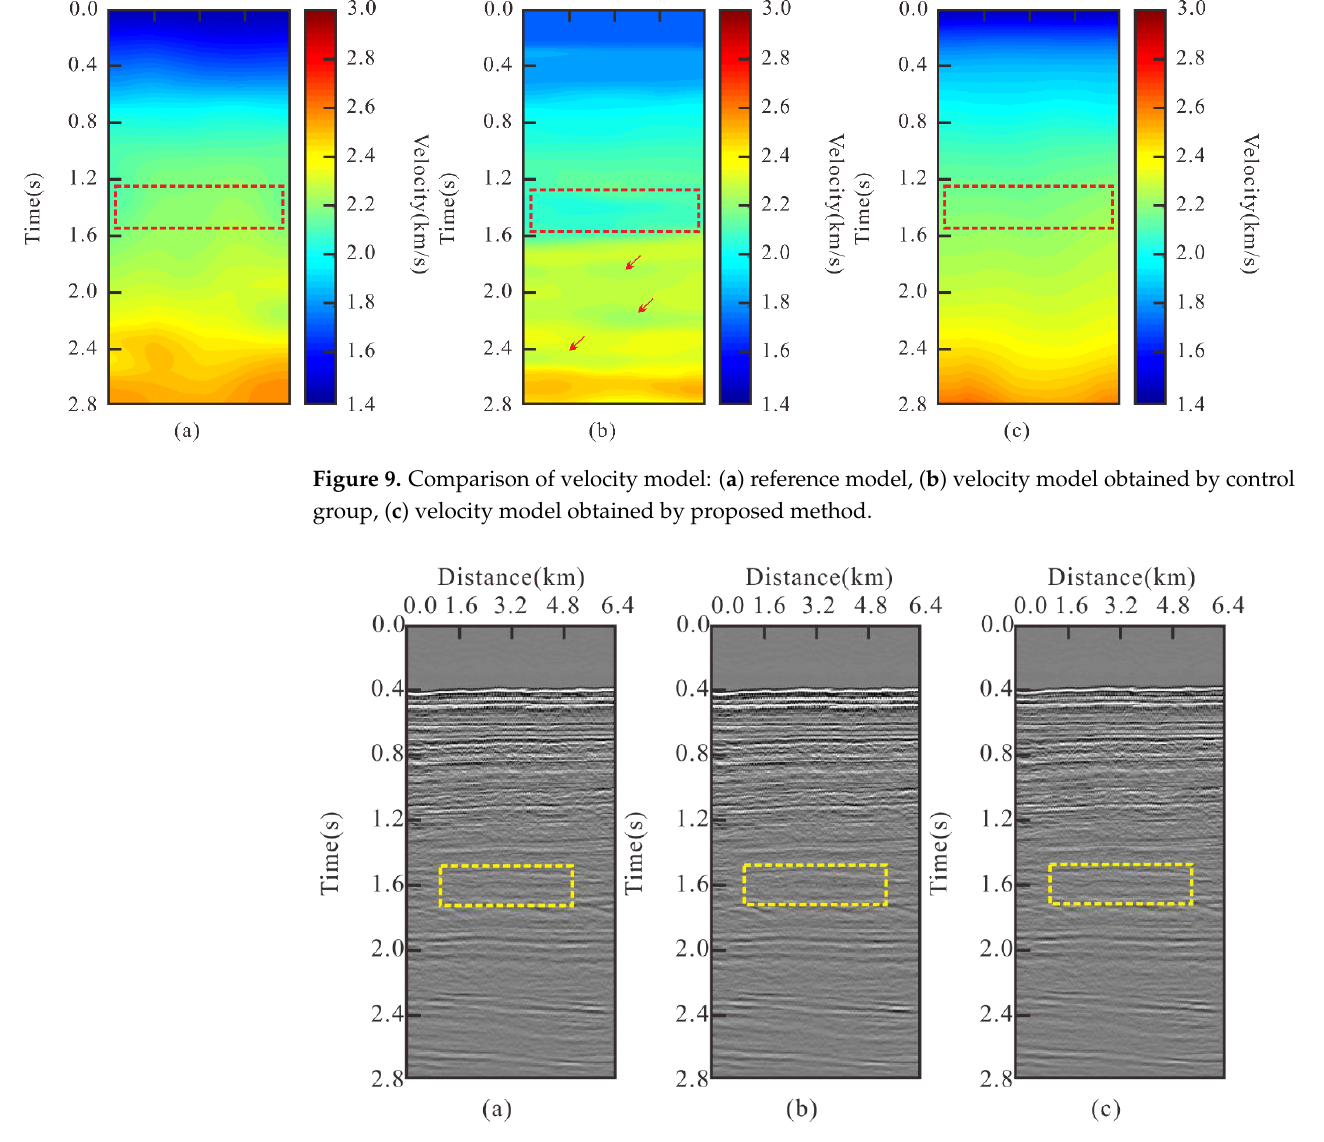
Figure 9. Comparison of velocity model: ( a ) reference model, ( b ) velocity model obtained by control group, ( c ) velocity model obtained by proposed method.